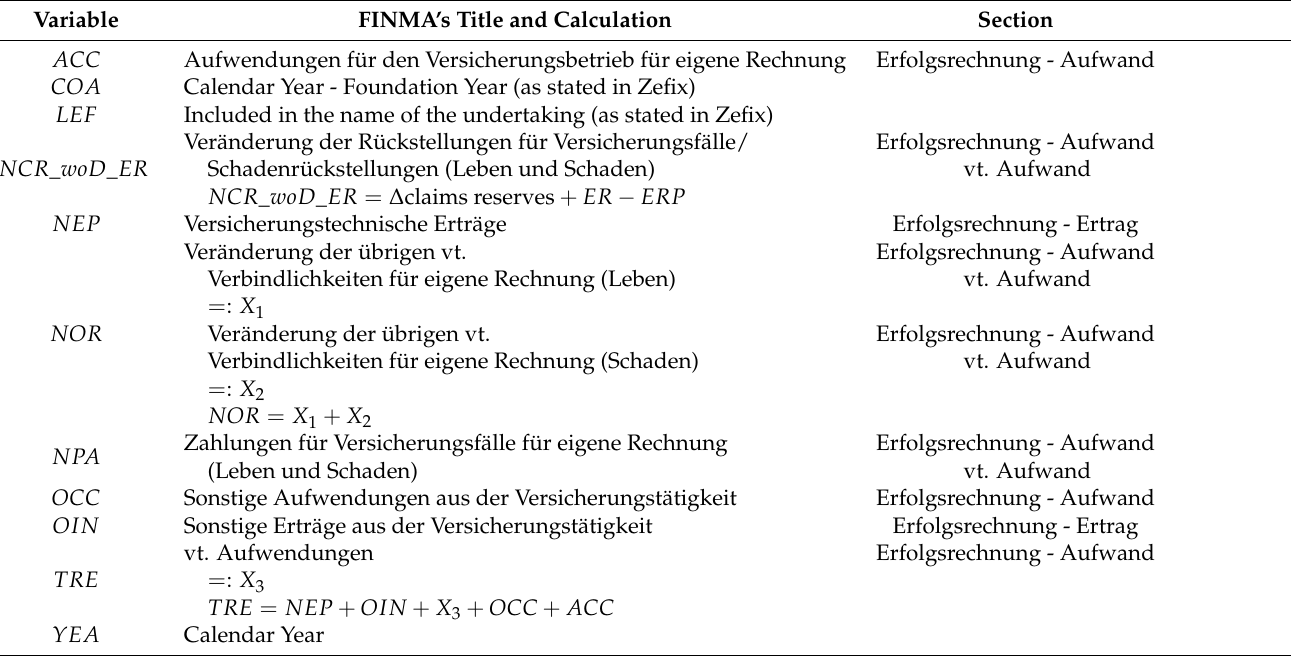
Table A2. FINMA published the data within a “cube” for the years 2008 to 2018. Section “Bilanz and Erfoglsrechnung” is the source of the available explanatory variables for reinsurance and non- life